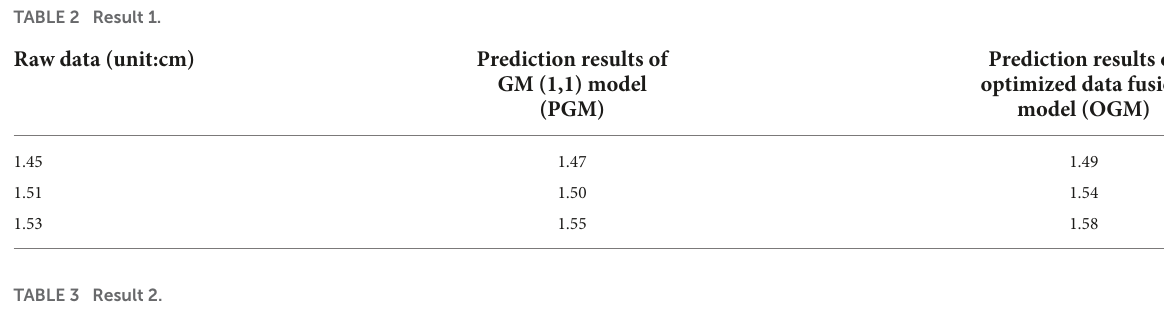
TABLE 2 Result 1.